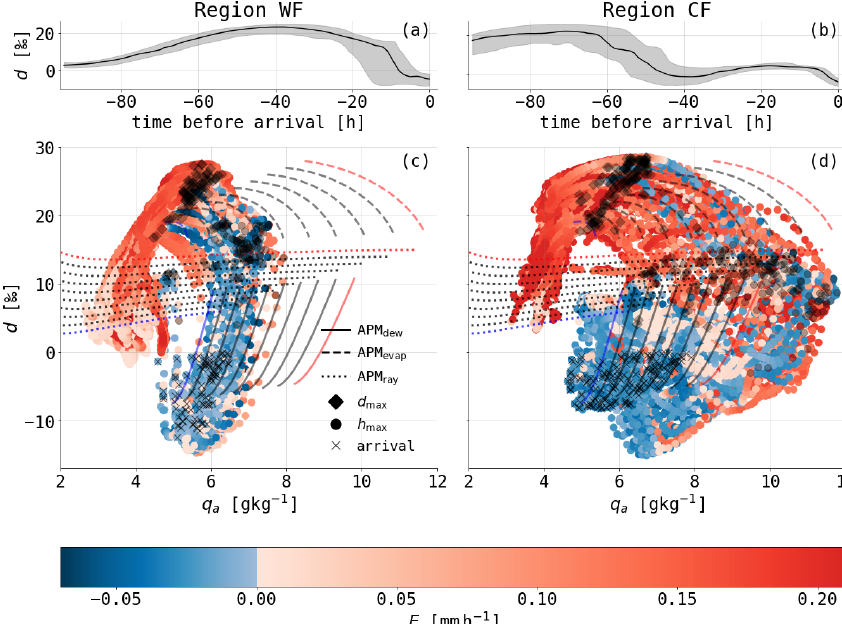
Figure 9. Evolution of d (median and [25, 75] percentile range) along 4d backward trajectories starting at 22:00UTC on 26 December 2016 below 50m (a) behind the warm front (region WF) and (b) ahead of the cold front (region CF). Phase space diagrams of d versus q a for (c) region WF and (d) region CF (hourly values along the trajectories are shown by dots, coloured by ocean evaporation ( E ), which is defined positive upward). The results of the APMs are shown by black lines, solid for APM dew , dashed for APM evap and dotted for APM ray . The red lines show the simulations with the highest SST ( T a for APM ray ) and the blue lines with the lowest. For details on the model setups, see Appendix Table B1 and text. Markers denote specific events along the trajectories: the time of highest d (black diamond), the time of highest h s (black dot) and the time of arrival at the measurement site (black cross).